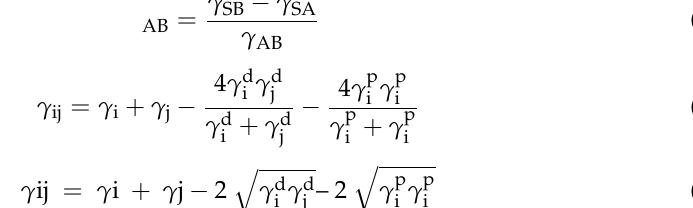
Table 2. Localization of particle (S) depending on wetting parameter .